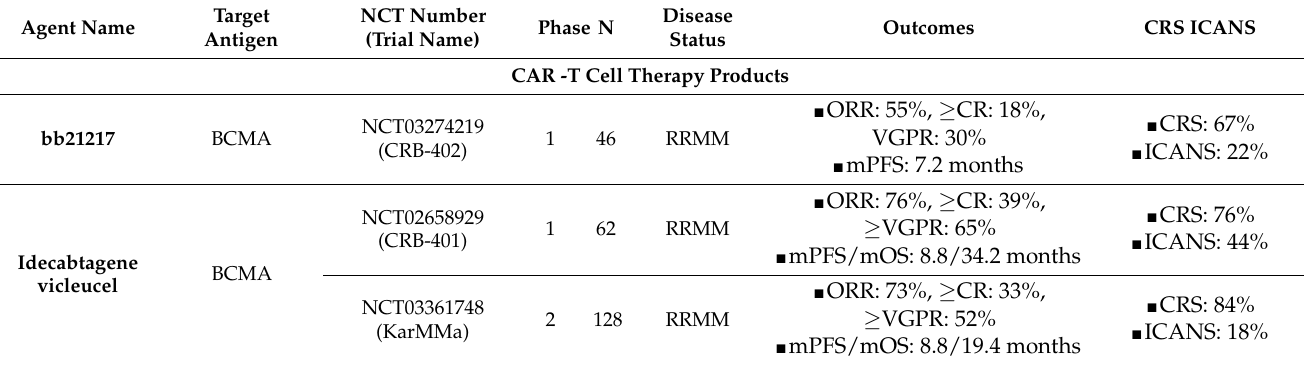
Table 2. Major CAR T cell and Bispecific Antibody Clinical Trials with reported outcomes in